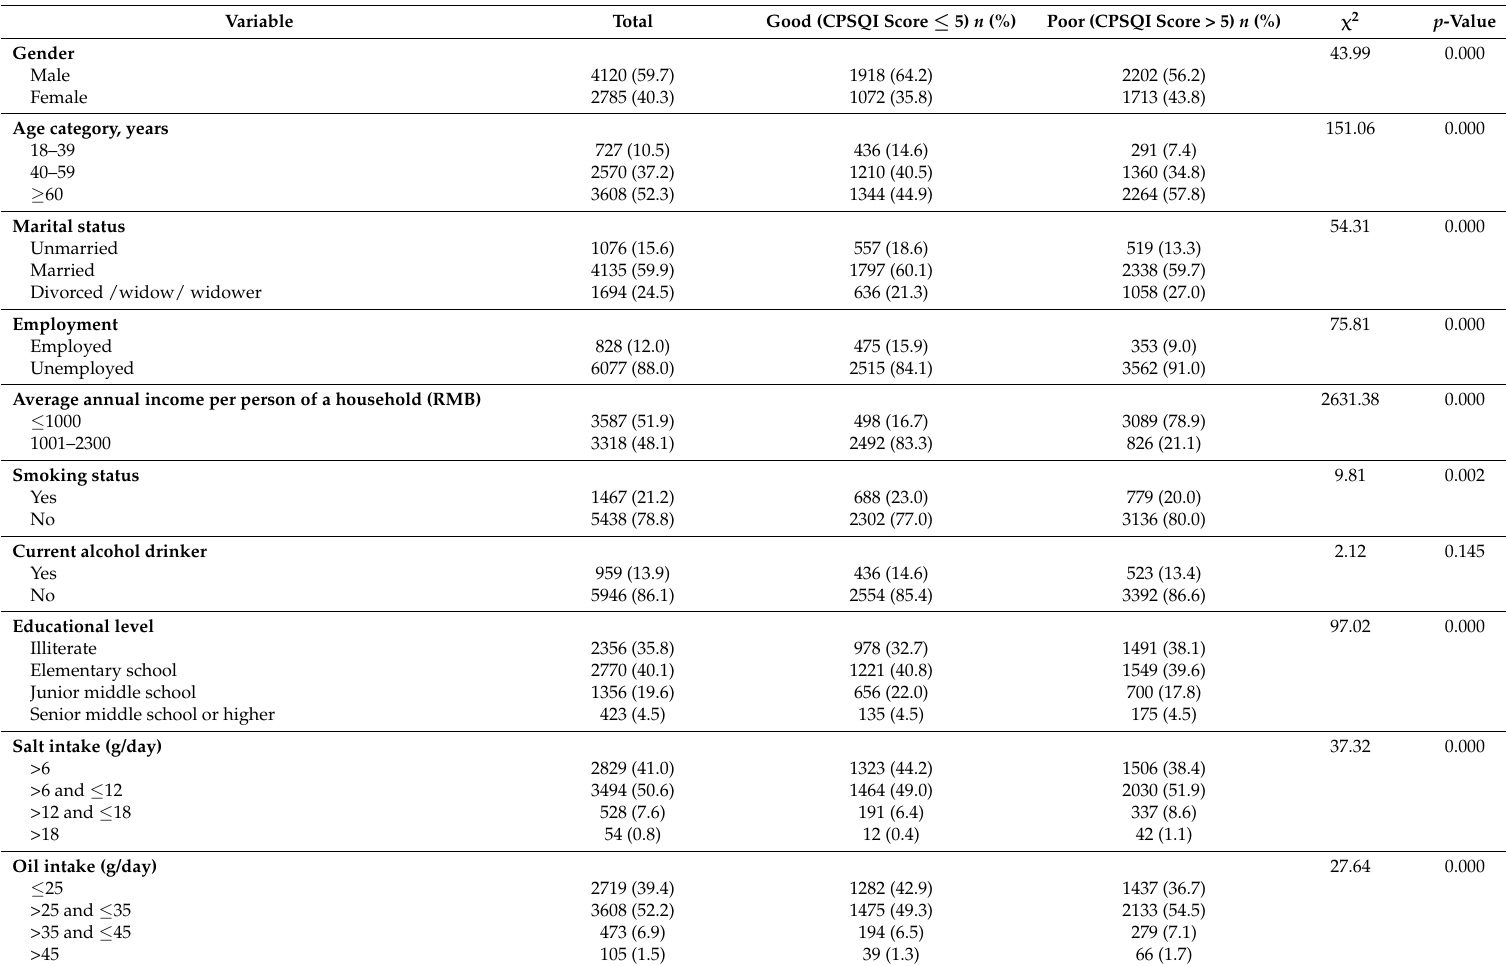
Table 1. Participant characteristics by sleep